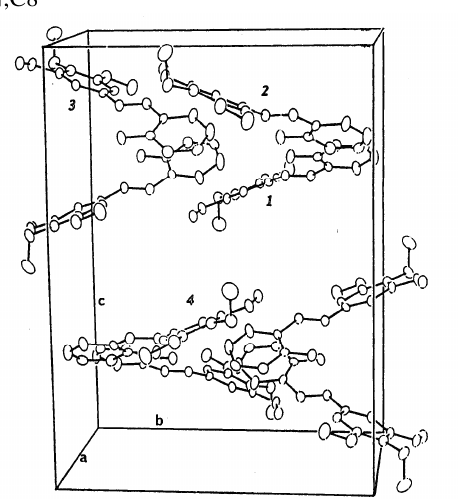
Figure 2. Packing diagram of 3,4,5-trimethoxy N -(2-hydroxybenzylidene)